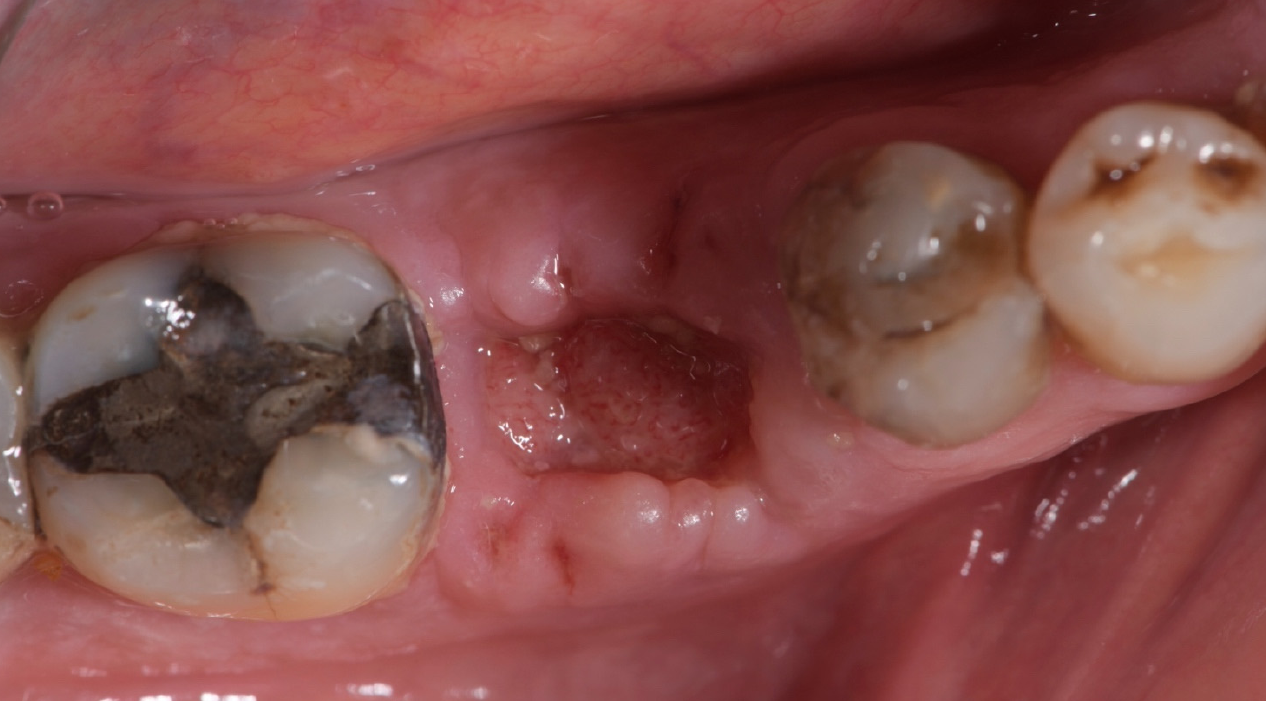
Figure 7. Occlusal view 2 weeks after tooth extraction and socket preservation procedure.